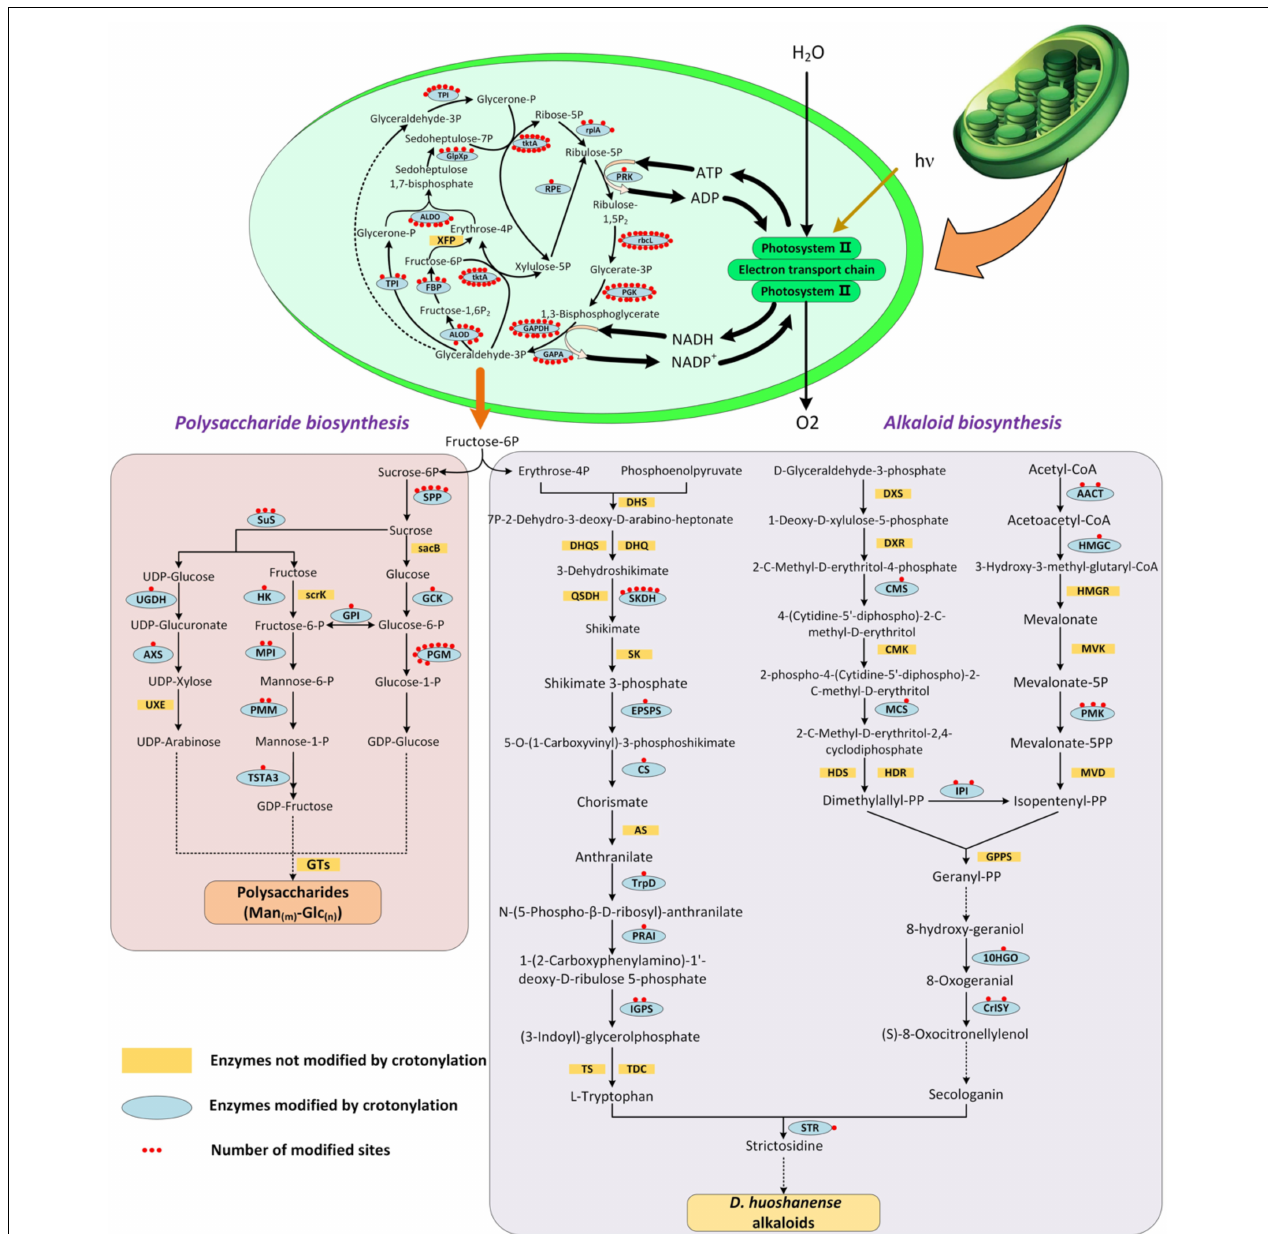
FIGURE 7 | Crotonylated enzymes were involved in Calvin cycle, polysaccharide biosynthesis, and alkaloid biosynthesis pathways of D. huoshanense . Yellow box referred to enzymes not modified by crotonylation. Blue oval referred to enzymes modified by crotonylation. Red dots indicated crotonylated sites in each